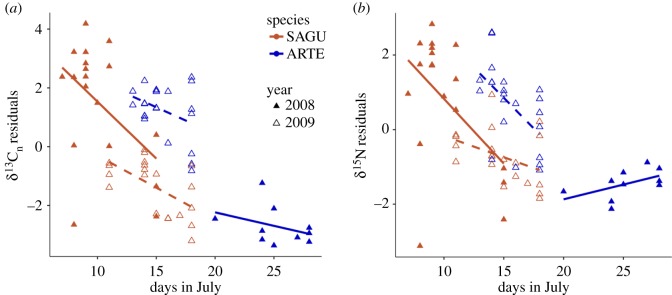
Relationship between date sampled and the residuals extracted from GLM models with only species and year as fixed effects to show the significant influence of date sampled on the variation in (a) δ13Cn and (b) δ15N for Sabine's gull (SAGU; orange) and Arctic tern (ARTE; blue) in 2008 (filled) and 2009 (open) at Nasaruvaalik Island. Trend lines represent the best linear fit to visually display the direction of the relationship for δ13Cn and δ15N for each year and species.